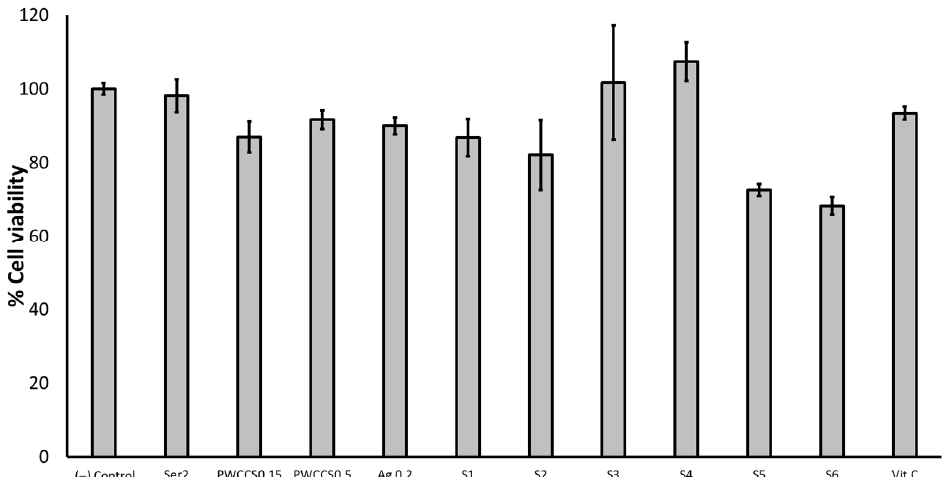
Figure 7. Viability of the HaCaT cells exposed to 2% sericin (Ser2), 0.15% PWCCS (PWCCS0.15), 0.5% PWCCS(PWCCS0.5), 0.2% alginate (Ag0.2), 25 μ g /mL ascorbic acid (Vit C), and the formula- tions S1–S6 for 6 h. Data represent the mean ± SEM of the three